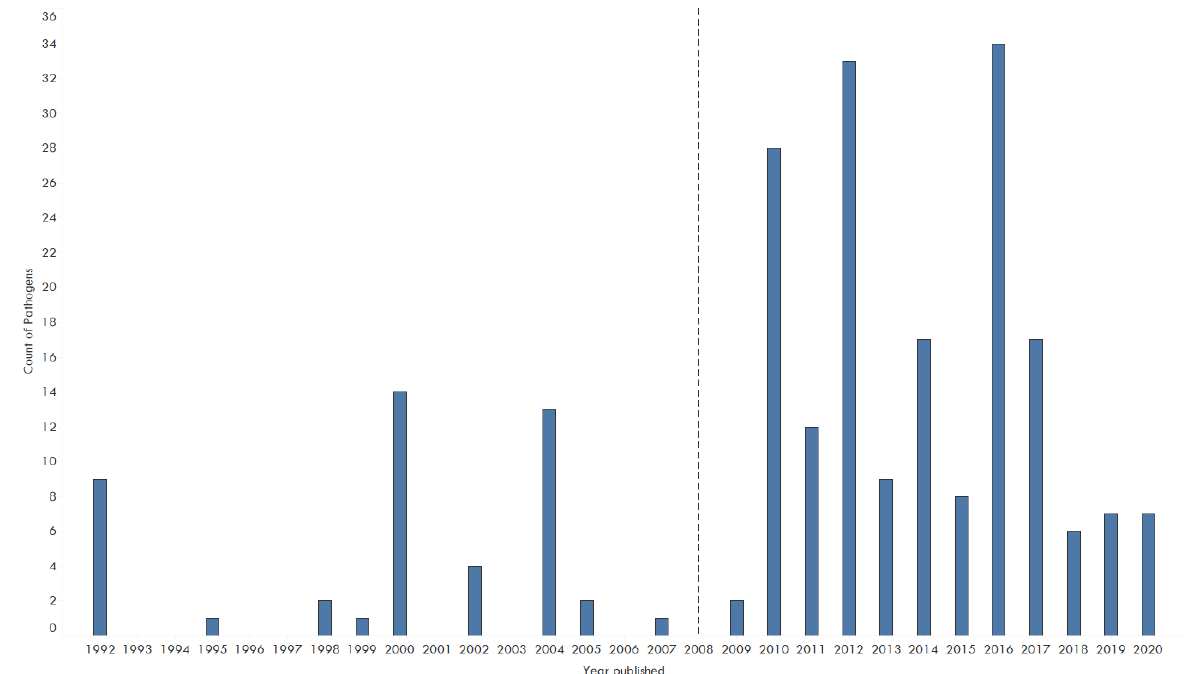
Figure 2. Number of species identified by taxa reported by unique illegal wildlife trade events (top) and cumulative total count of species traded over time, 1990–2020. The reference line indicates the publication of the last review in 2008 [9] in which no amphibian illegal trade was documented.